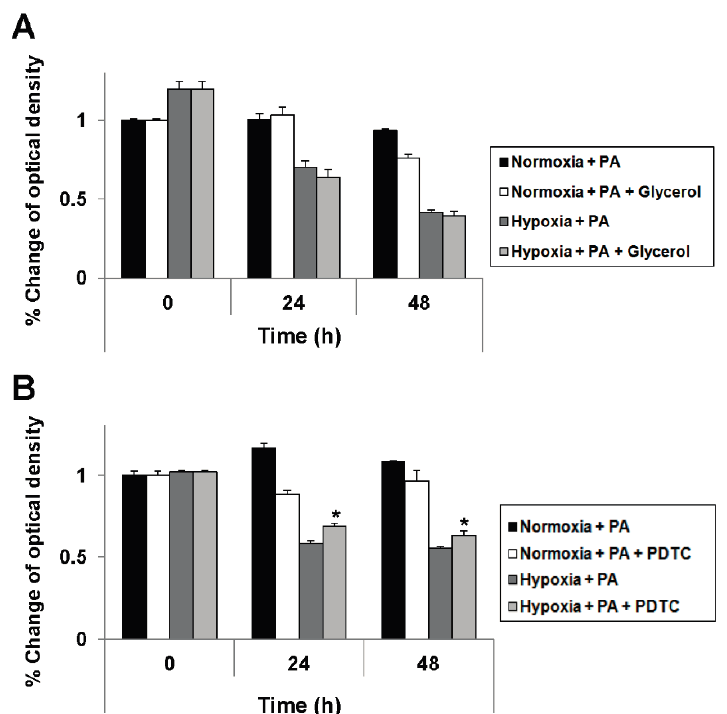
Figure 5. Attenuation of hypoxia-exacerbated lipoapoptosis by pyrrolidine dithiocarbamate (PDTC). HepG2 cells were cultured in the absence or presence of glycerol (1%) under either standard or hypoxic culture conditions ( A ); HepG2 cells were cultured in the absence or presence of PDTC (0.6 mM) under either standard or hypoxic culture conditions ( B ). At each indicated time point, an MTS assay was performed according to the manufacturer’s